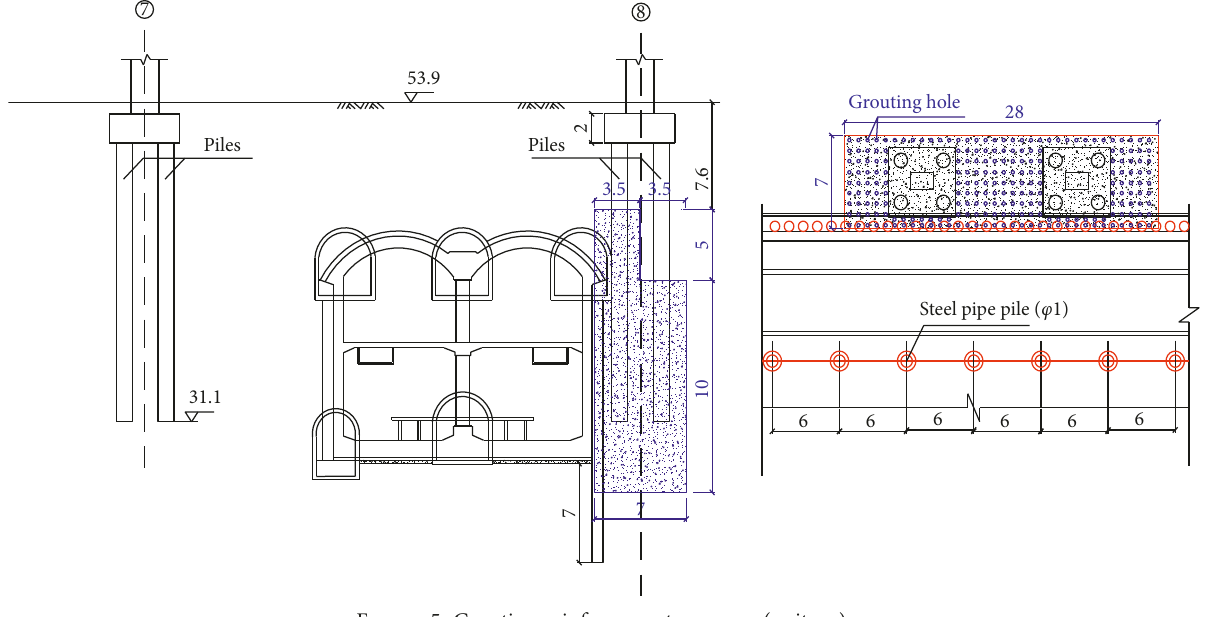
Figure 5: Grouting reinforcement measure (unit: m).